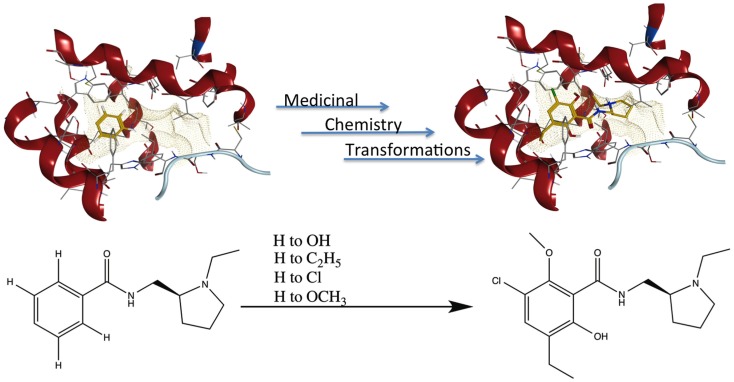
Fragment growing in MedChem Transformations. Upper panel: in theory, a starting fragment as simple as a benzene ring (yellow) can be grown into the D2/D3 antagonist eticlopride (yellow with atomtype-colored heteroatoms) within the D3 receptor (red) binding pocket with multiple MCT iterations. Lower panel: MCT chemistry in regenerating four substituent groups removed from eticlopride.